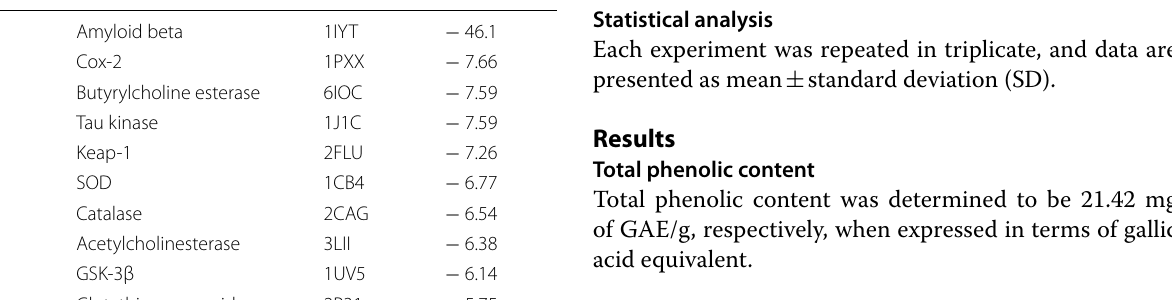
Table 7 Binding energy of perlolyrine with selected targets S. no